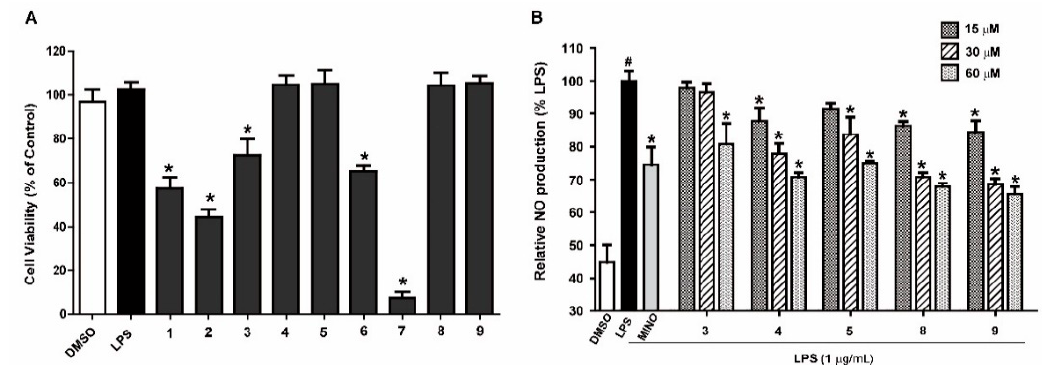
Figure 4. Cell viability of 1 – 9 against RAW 264.7 cells ( A ). Effect of 3 – 5 , 8 and 9 on the inhibition of LPS-induced NO in RAW 264.7 cells ( B ). Cells were incubated with compounds or minocycline (MINO, 25 µ M) for 2 h then stimulated with or without LPS (1 µ g/mL) for 24 h. Cell viability was evaluated by MTT assay. The NO production in the medium was measured using Griess agent. All conditions were run in triplicate, and data show mean ± SD values. # , p < 0.05 was compared to control. *, p < 0.05 compared to LPS.